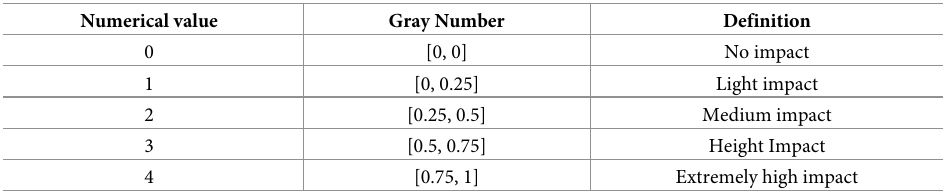
Step 3 Convert average grey matrix into crisp relationship